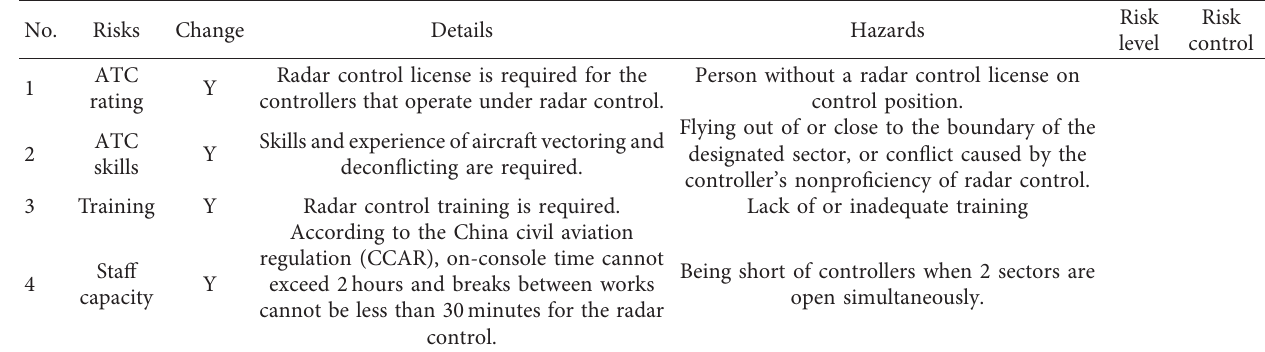
Table 3: Safety assessment of “MAN” category